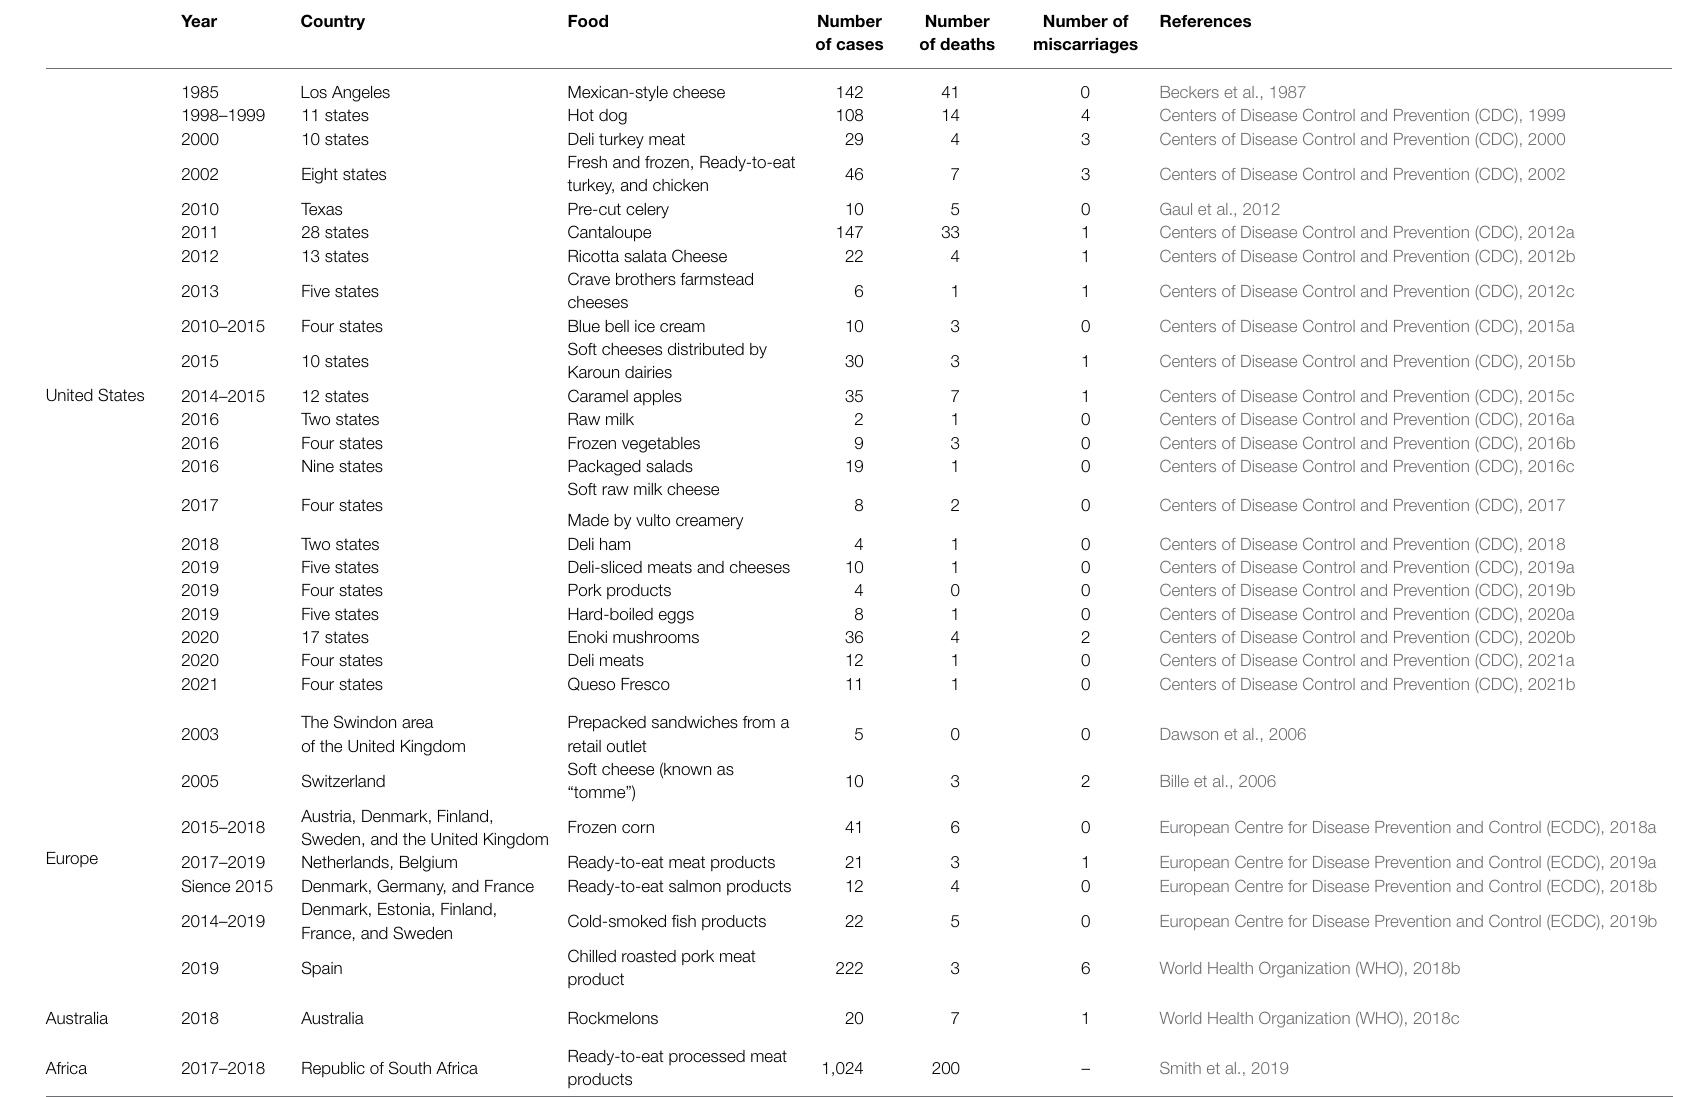
TABLE 1 | The most important epidemics of